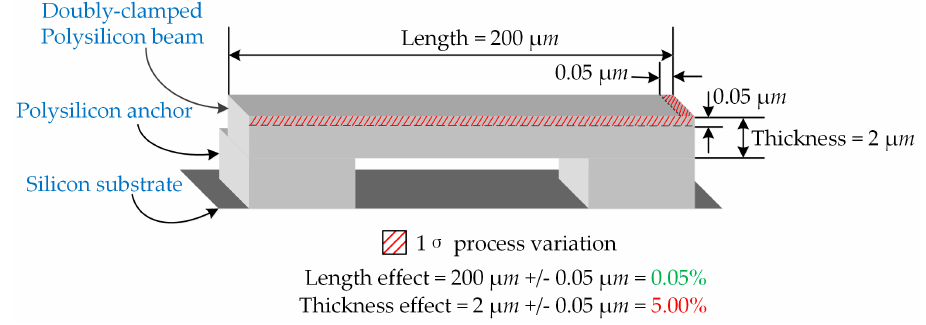
and and 200 ± 0.05 µ m 200 ± 0.05 µ m